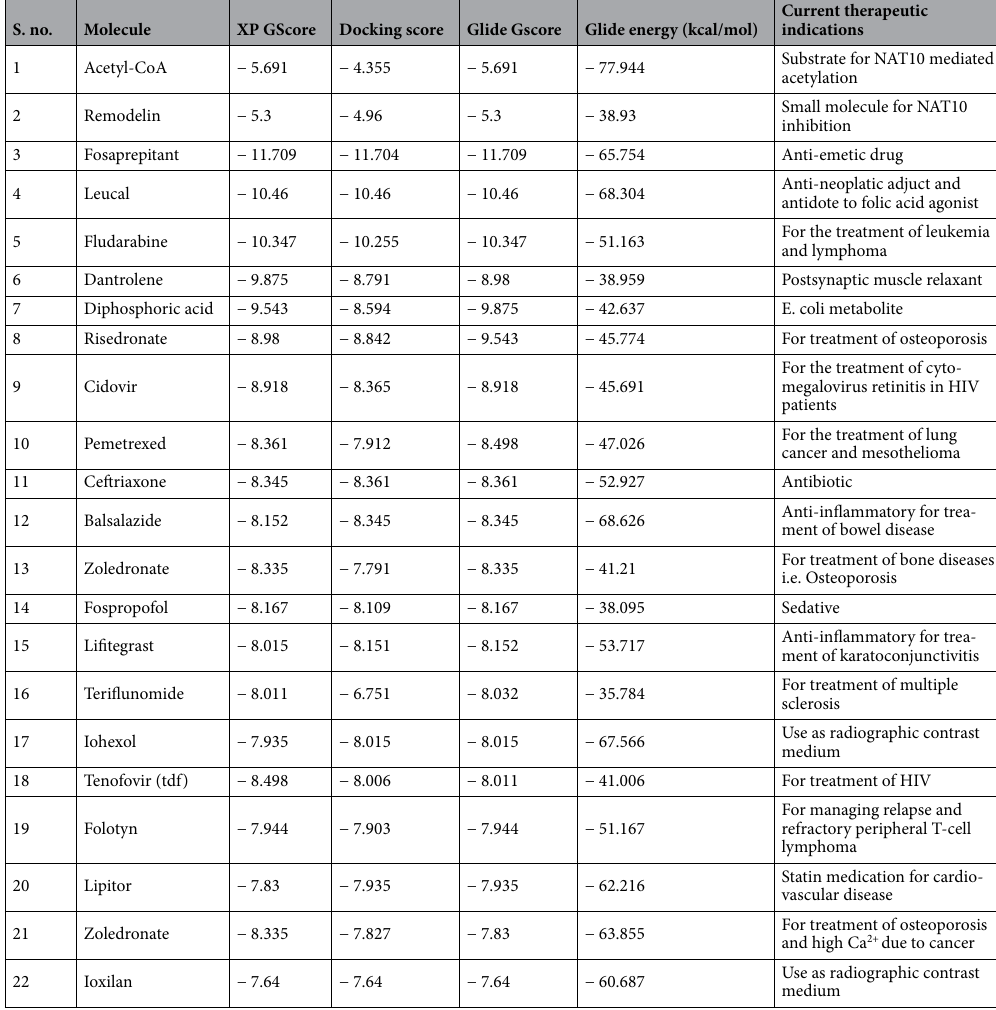
Table 1. Acetyl-CoA, Remodelin and top 20 shortlist drugs by SP-docking for targeting